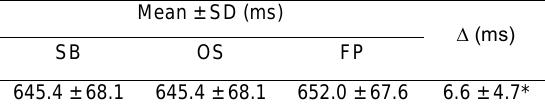
Table 2. Comparison of ground contact time measurement by the SaltoBras and Force Plate (n=30).